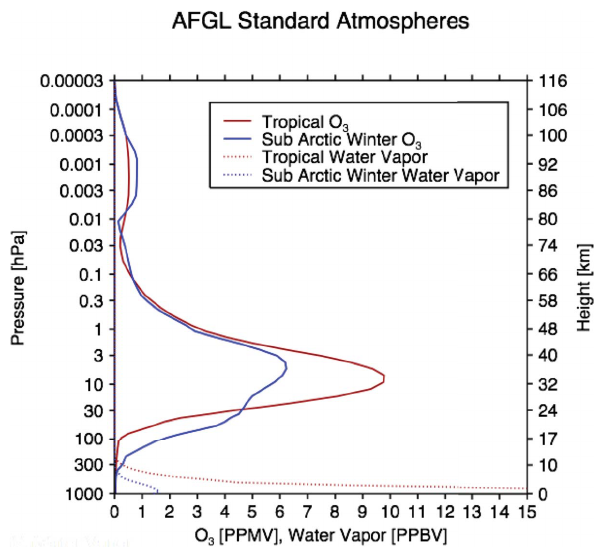
Fig. 1. Prescribed AFGL profiles of Ozone (O 3 ) and Water Vapor (H 2 O).